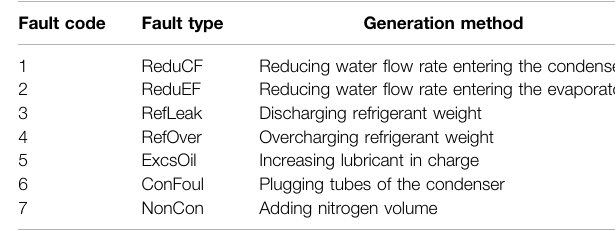
TABLE 1 | Fault types and their corresponding generation